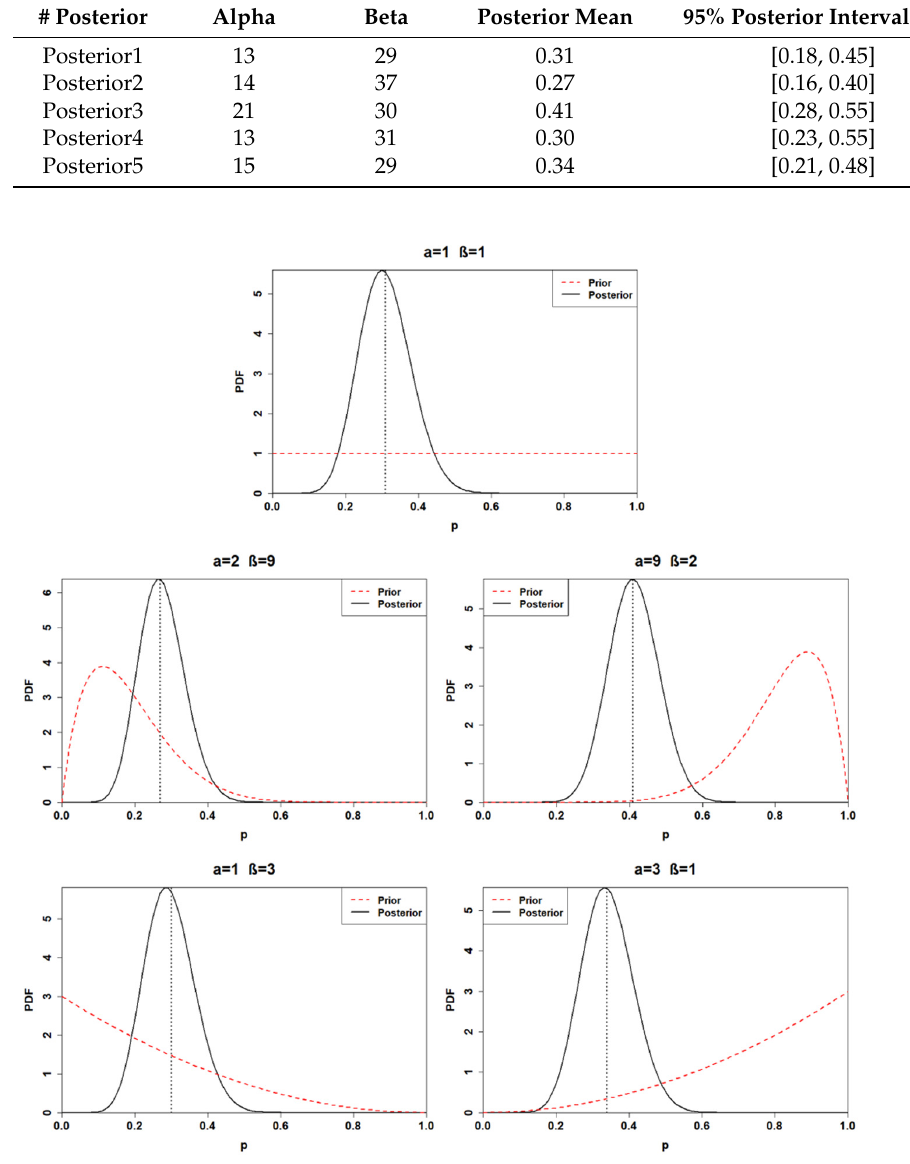
Figure 3. Posterior distributions of the third application (sample with n = 40, k = 12) for distinct choices of prior. The black dashed lines represent the posterior mean values.